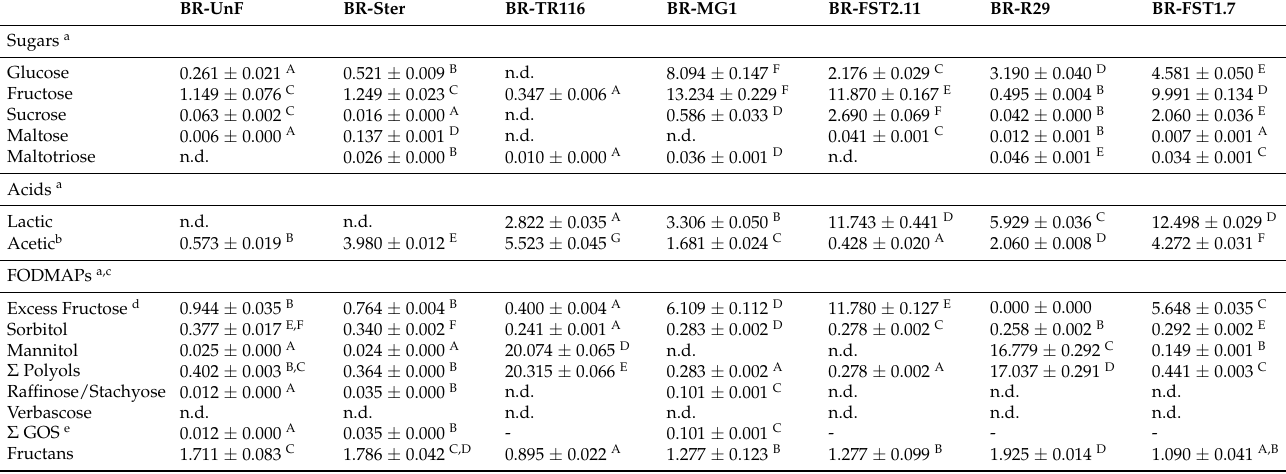
Table 2. Quantities of residual carbohydrates and acids in rootlet ingredients. BR-UnF and BR-Ster represent unfermented barley rootlet and sterilised barley rootlets, respectively. BR-TR116, BR- MG1, BR-FST2.11, BR-29 and BR-FST1.7 represent results for barley rootlets after 96 h fermentation, fermented with five different lactic acid bacteria: Leuconostoc citreum TR116, Weissella cibaria MG1, Lactobacillus amylovorus FST2.11, Limosilactobacillus reuteri R29 and Lactiplantibacillus plantarum FST 1.7, respectively. Values reported represent the mean ± standard deviation in g/100 g d.m. Values in the same row which share the same uppercase letter do not differ significantly.